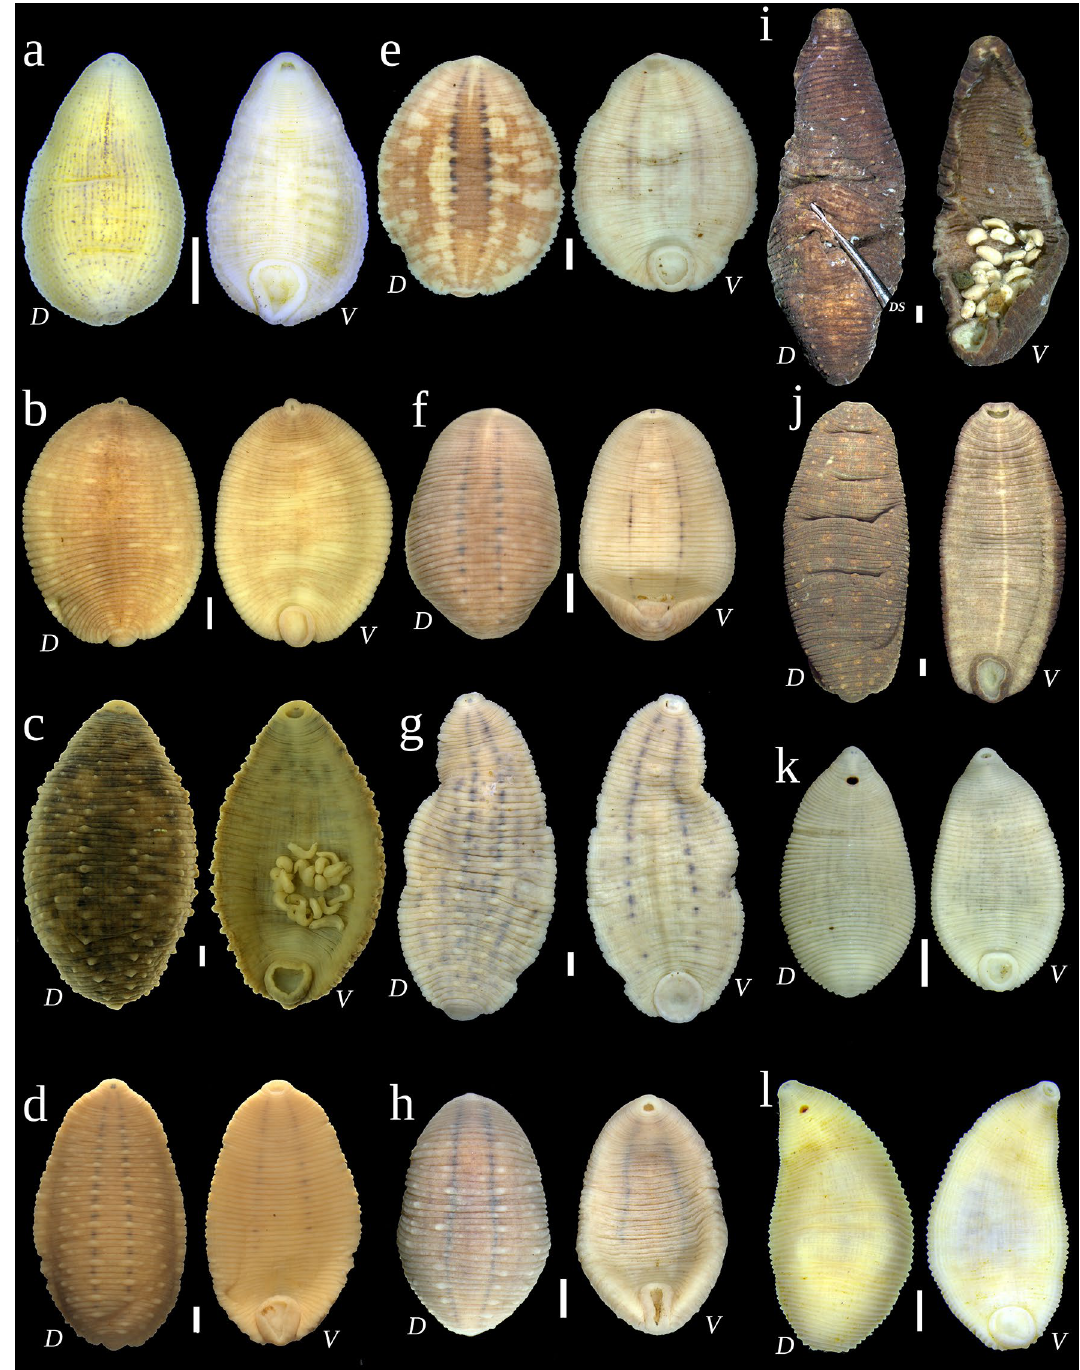
Figure 4. Dorsal ( D ) and ventral ( V ) views of Glossiphoniidae species under discussion. ( a ) Alboglossiphonia sibirica sp. nov. (holotype RMBH Hir_0542_2-H, Primorye). ( b ) Glossiphonia arctica sp. nov. (holotype RMBH Hir_0457_2_1-H, Polar Urals). ( c ) G. verrucata (melanic form; specimen RMBH Hir_0605_1, Putorana Plateau). ( d ) G. mollissima (light-colored form; specimen RMBH Hir_0188_2, Yakutia Republic). ( e ) G. taymyrensis sp. nov. (melanic form; holotype RMBH Hir_0258_1-H, Taymyr). ( f ) G. balcanica (light- colored form; specimen RMBH Hir_0250, Kola Peninsula). ( g ) G. concolor (specimen RMBH Hir_0263_2, Taymyr). ( h ) G. nebulosa (specimen RMBH Hir_0261_1, Taymyr). ( i ) Theromyzon maculosum (melanic form; specimen RMBH Hir_0263_3, Taymyr). ( j ) Hyperboreomyzon polaris gen. & sp. nov. (holotype RMBH Hir_0486-H, Putorana Plateau). ( k ) Helobdella stagnalis (specimen RMBH Hir_0269, Taymyr). ( l ) H. okhotica sp. nov. (holotype RMBH Hir_251_1-H, Chukotka Peninsula). Abbreviations: DS , dissecting needle. Scale bars = 1.0 mm. Photos: Anna L. Klass and Tatyana A.